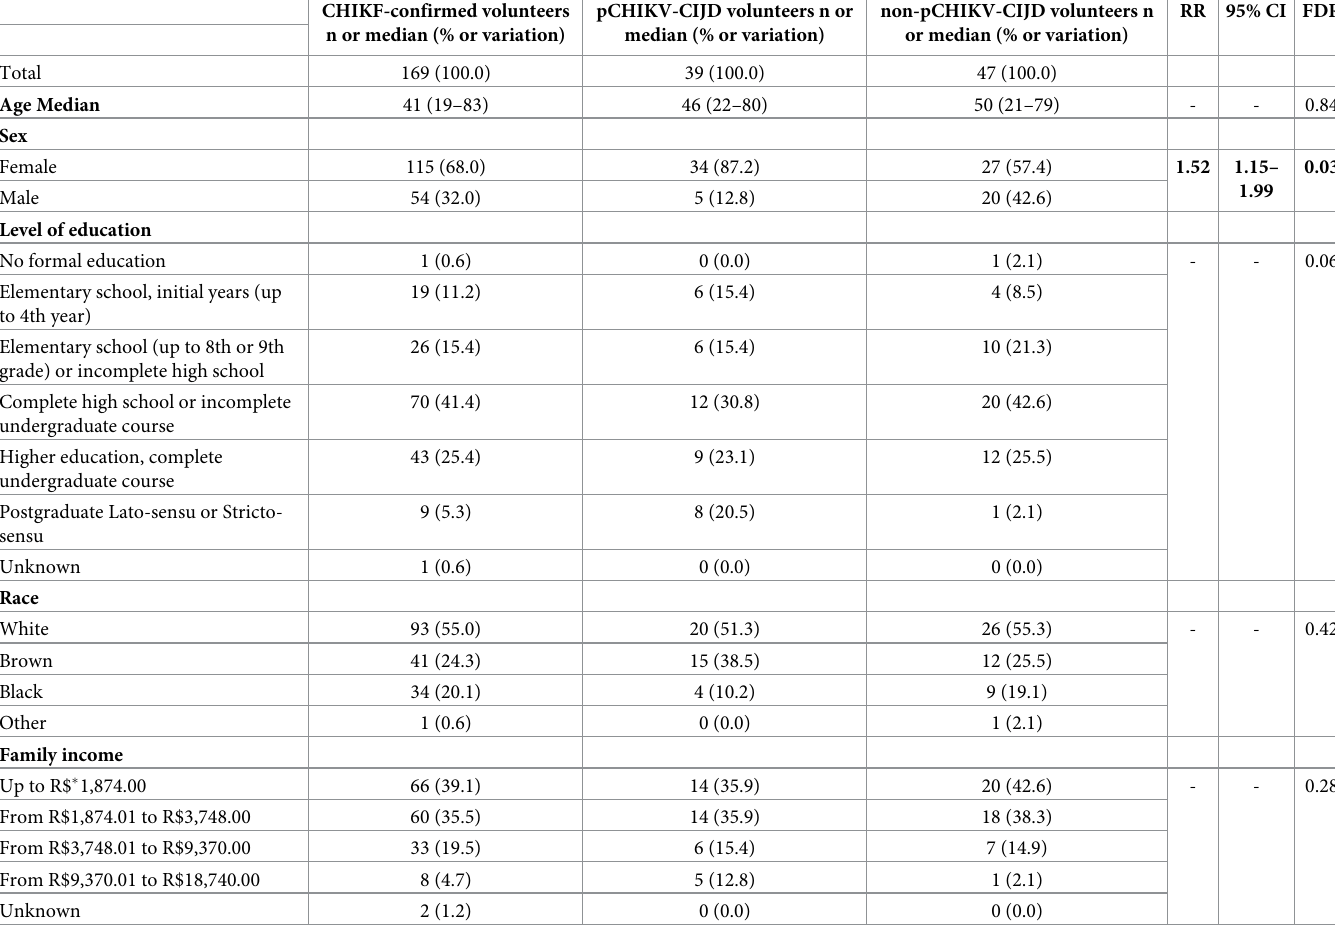
Table 2. Socio–demographic data of volunteers with confirmed